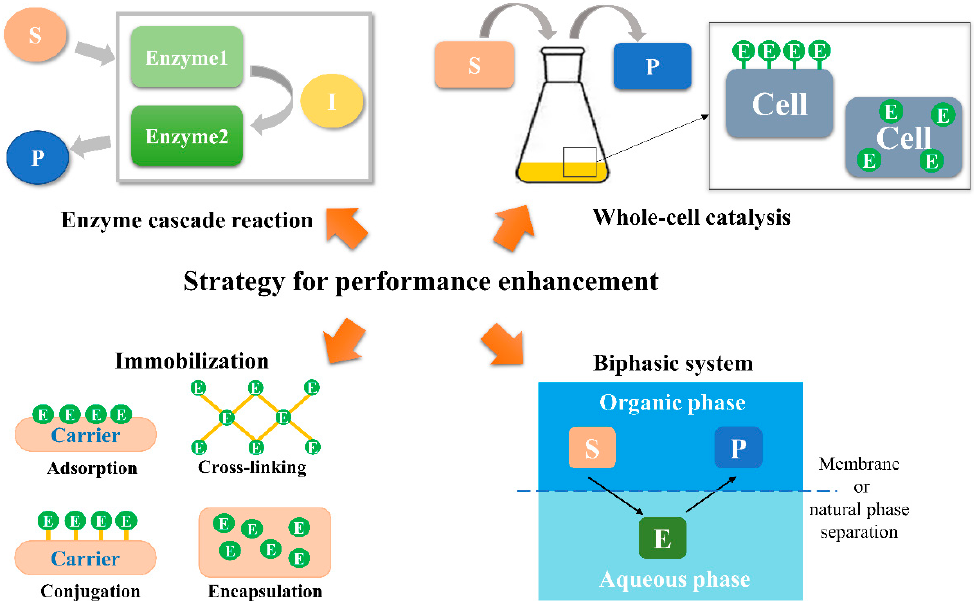
Figure 4. Strategies for performance enhancement based on α / β hydrolases. “S”, substrate; “I”, intermediate; “P”, product; “E”, enzyme.